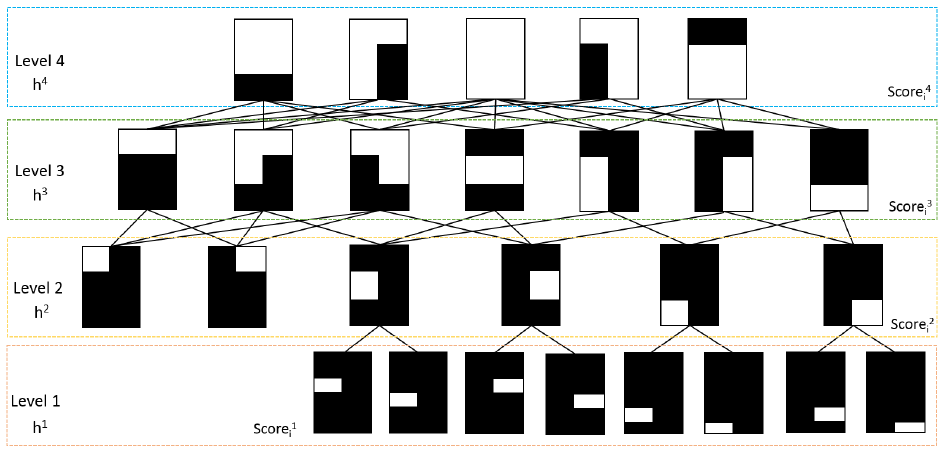
indicates the visibility state parameters of i